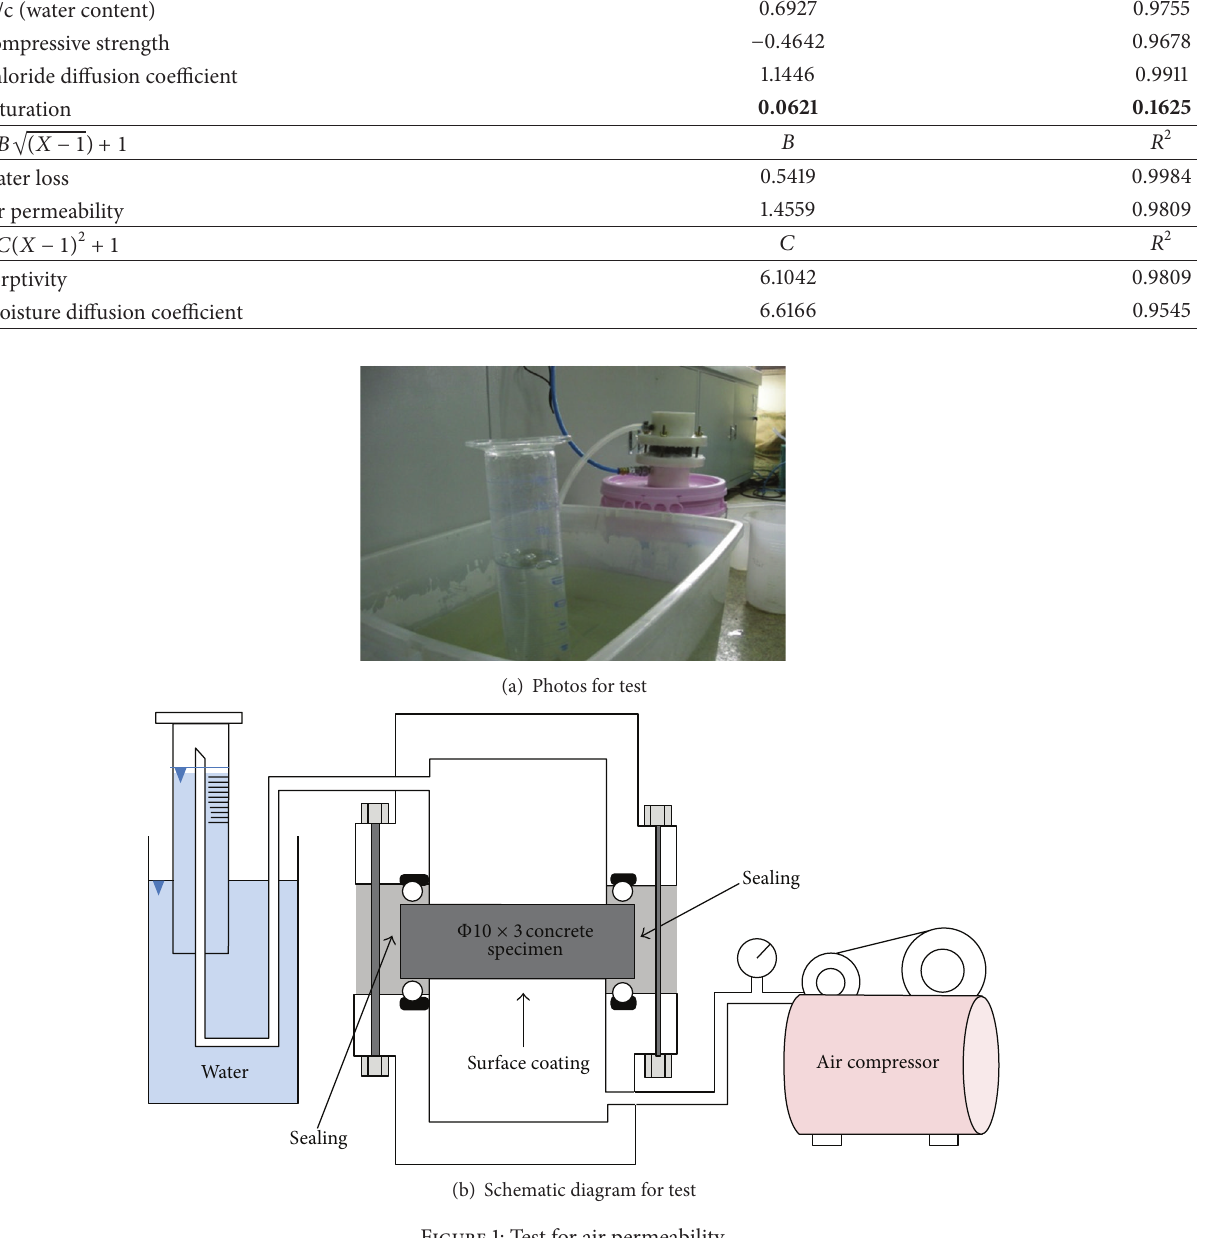
Figure 1: Test for air